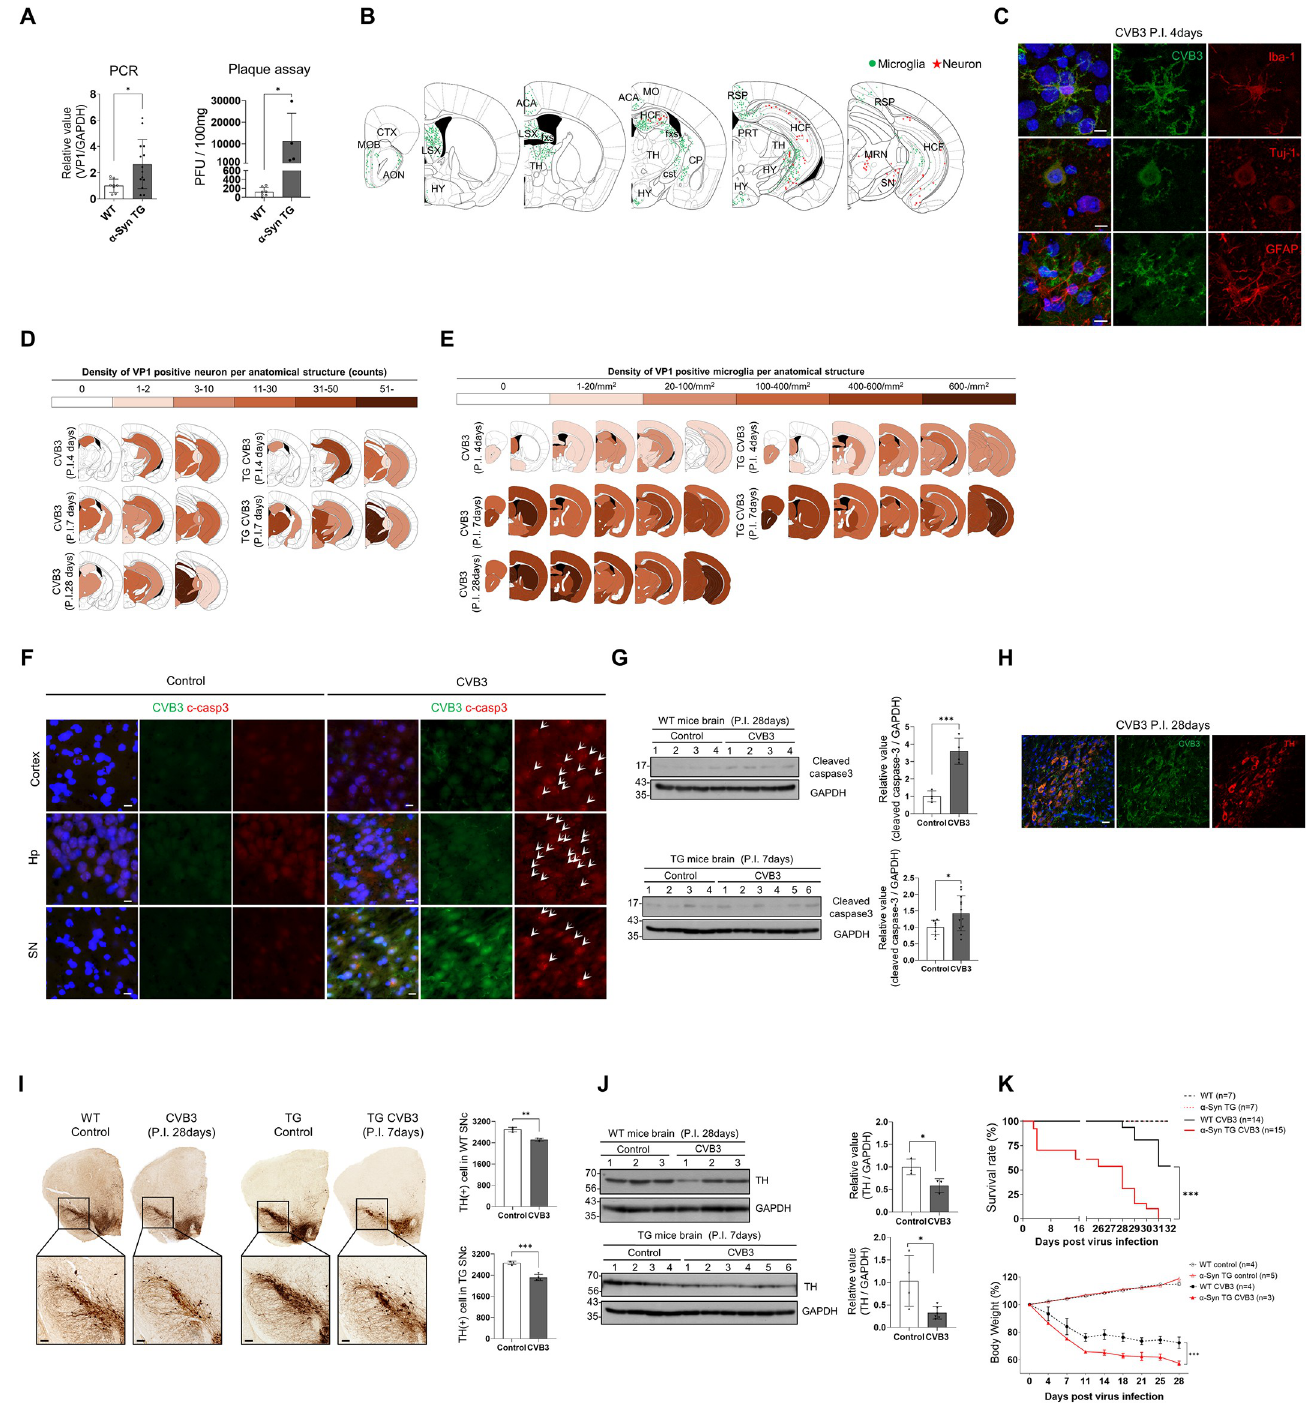
Fig 6. α -Syn regulates CVB3 replication in mice brains. (A) The relative levels of VP1—as analyzed by PCR—between WT (n = 8) and α -syn TG (n = 14) mice brains, and plaque assay between WT (n = 7) and α -syn TG (n = 4) mice brains at day 7 post infection (PI). Mice were infected by IP injection of 1.0 × 10 6 PFUs of CVB3. � P < 0.05, unpaired t-test. (B) Immunohistochemistry (IHC) images showing the localization of VP1-positive cells in mouse brain regions at day 4 PI. Microglia and neurons are indicated as green and red asterisks, respectively. (Abbreviations: mouse brain regions: CTX-cortex, MOB-main olfactory bulb, AON- anterior olfactory nucleus, LSX-lateral septal complex, HY-hypothalamus, ACA-anterior cingulate area, fxs-fornix system, MO-somatomotor area, HCF- hippocampal formation, TH-thalamus, CP-caudoputamen, Cst-corticospinal tract, RSP-retrosplenial area, PRT-pretectal region, MRN-midbrain reticular nucleus, SN-substantia nigra). (C) IHC images of CVB3 infected mice brains at day 4 PI (IP injection of 1.0 × 10 6 PFUs of CVB3). Colocalization of CVB3 VP1 (green) with